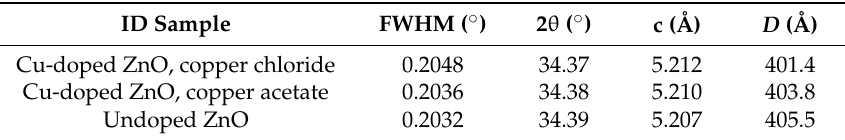
Table 1. Full width half maximum (FWHM or β ), angle of diffraction (2 θ ), lattice constant (c)